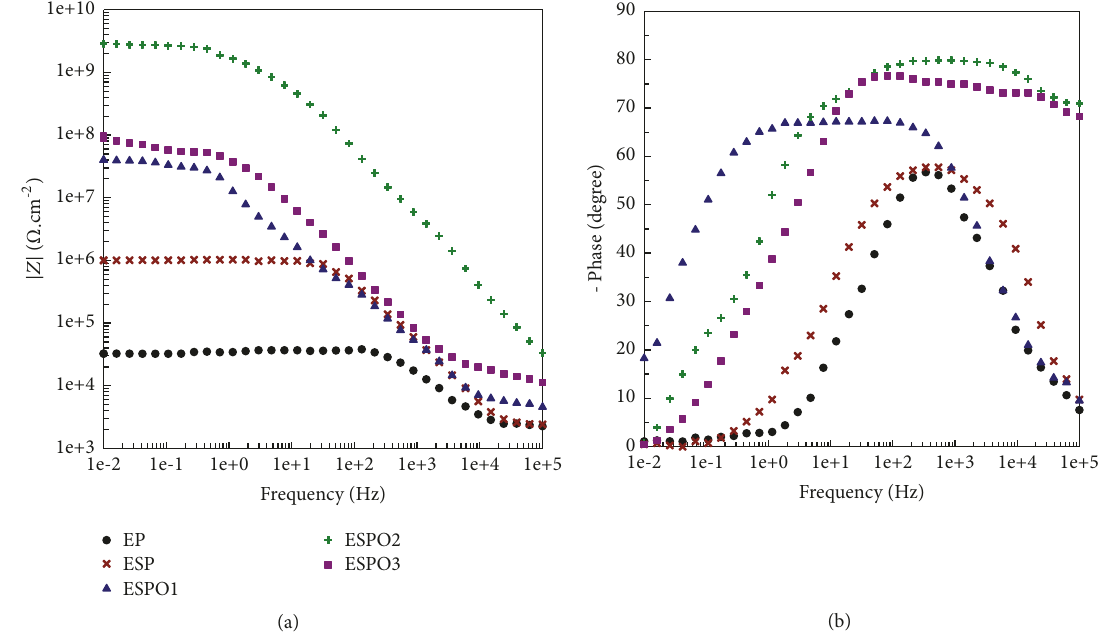
Figure 8: Bode plots of coatings after 14 days of immersion in 3% NaCl solution.